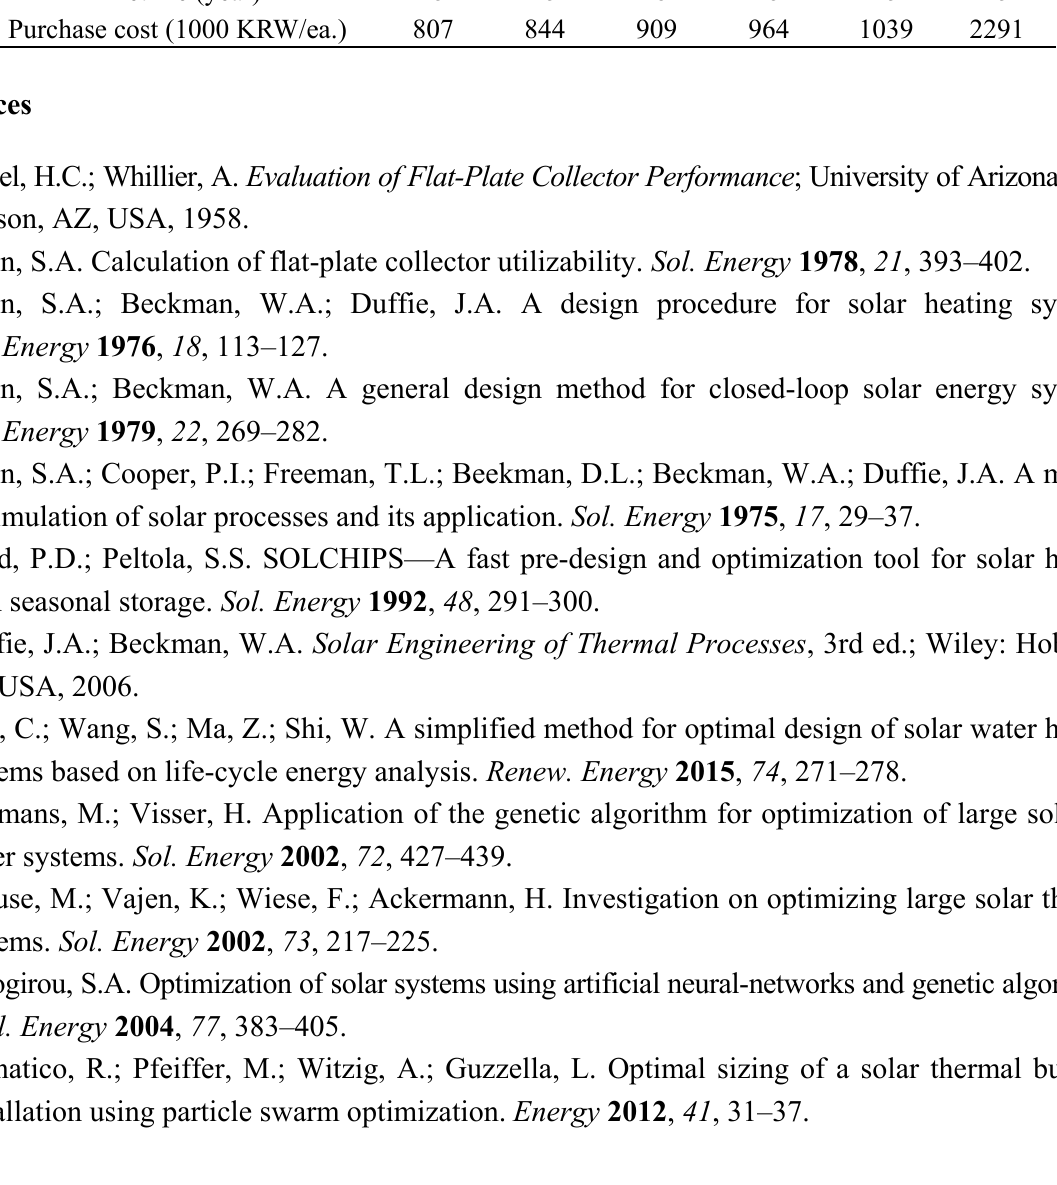
Purchase cost (1000